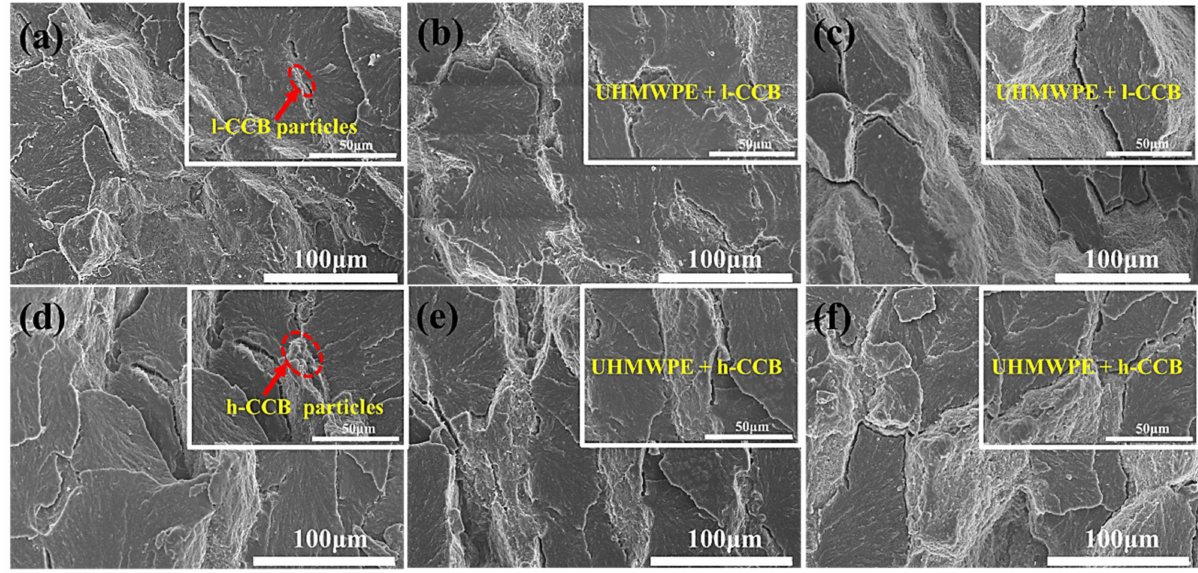
Figure 4. FE-SEM morphology of the cryo-fractured surface of UHMWPE/CCB composites: ( a ) UHMWPE/1-CCB 0.5 ; ( b ) UHMWPE/1-CCB 1 ; ( c ) UHMWPE/1-CCB 3 ; ( d ) UHMWPE/h-CCB 0.5 ; ( e ) UHMWPE/h-CCB 1 ; and ( f ) UHMWPE/h-CCB 3